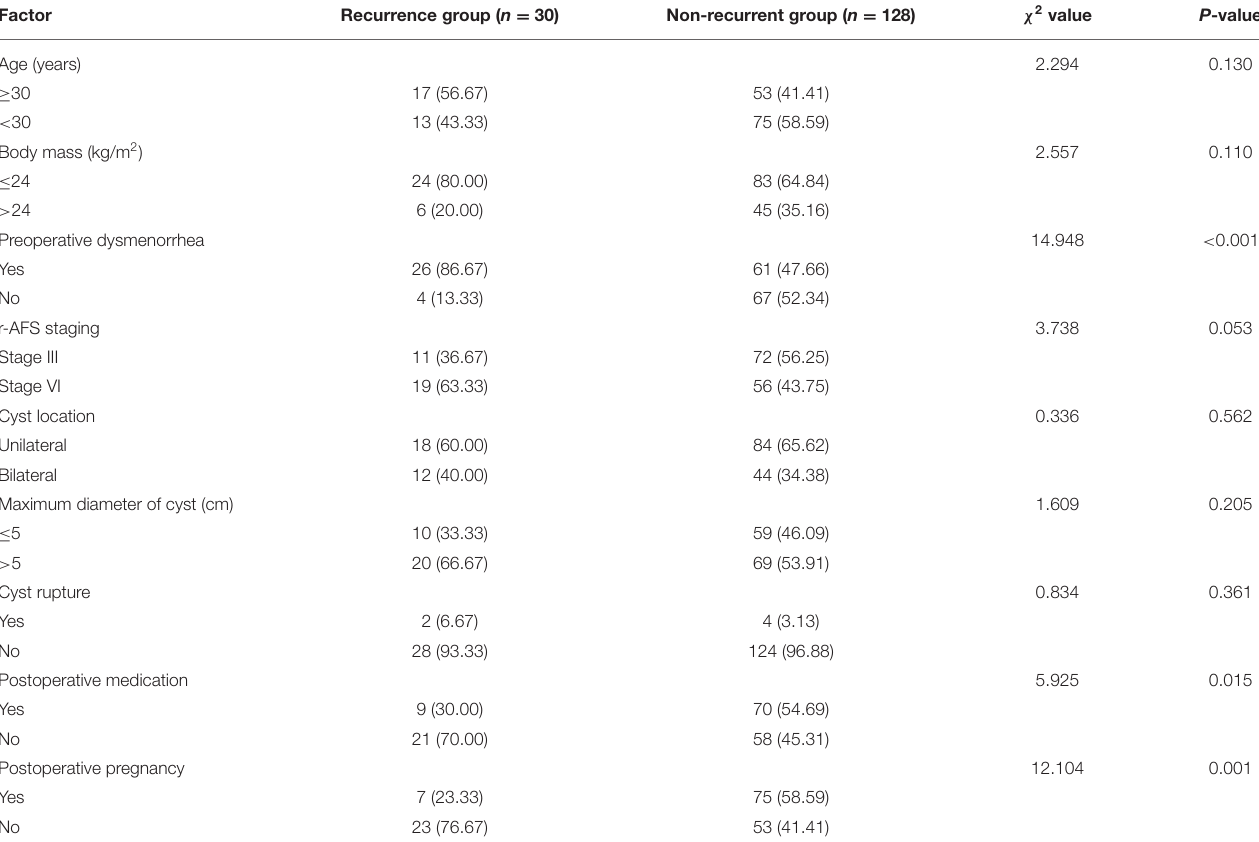
TABLE 1 | Univariate analysis of postoperative recurrence in patients with ems ( n ,%). Factor